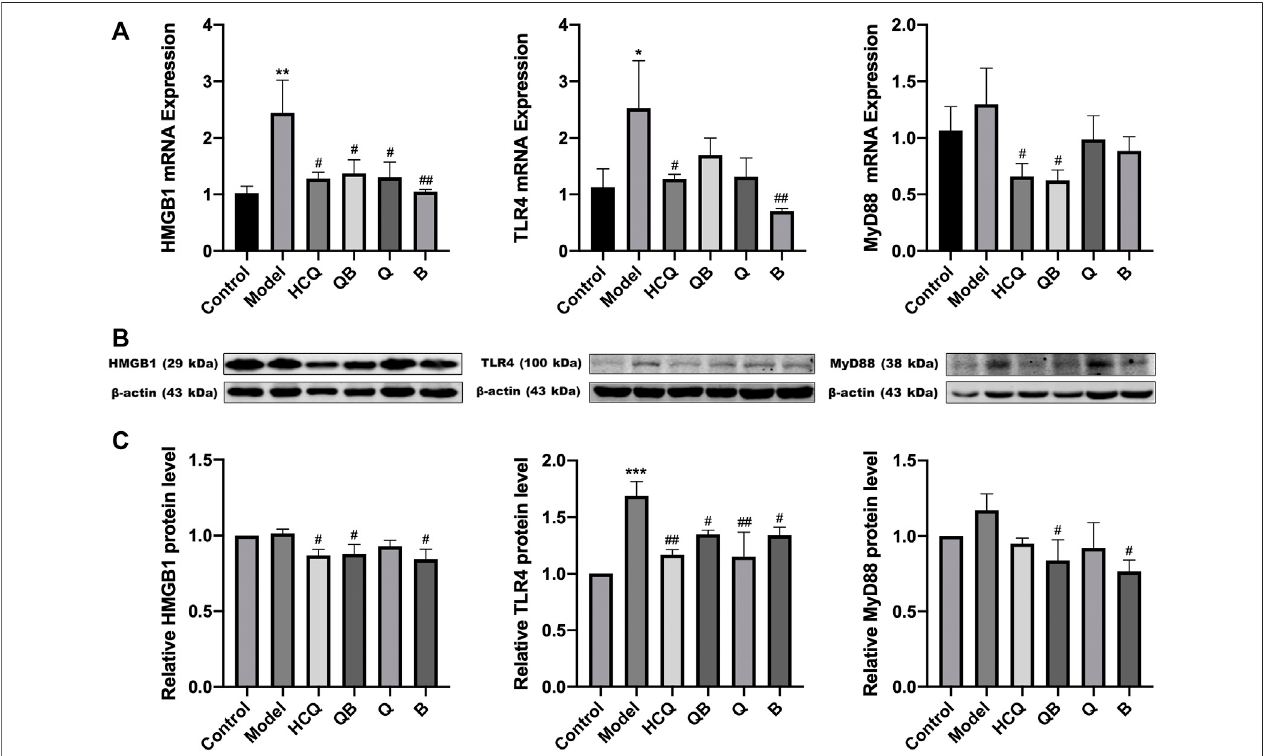
FIGURE 6 | Qinghao-Biejia can partly inhibit HMGB1/TLR4 pathway in kidneys. (A) The mRNA expression level of high mobility group box 1 protein (HMGB1), toll like receptor 4 (TLR4), and myeloid differentiation primary response 88 (MyD88) determined by RT-qPCR. (B) Band diagrams of HMGB1, TLR4, and MyD88 in kidney tissue of mice determined by western blot. (C) The expression level of HMGB1, TLR4, and MyD88 in kidney tissue of mice determined by western blot. Model group compared with the control group, * p < 0.05, ** p < 0.01, *** p < 0.001; the remaining groups compared with the model group, # p < 0.05, ## p <